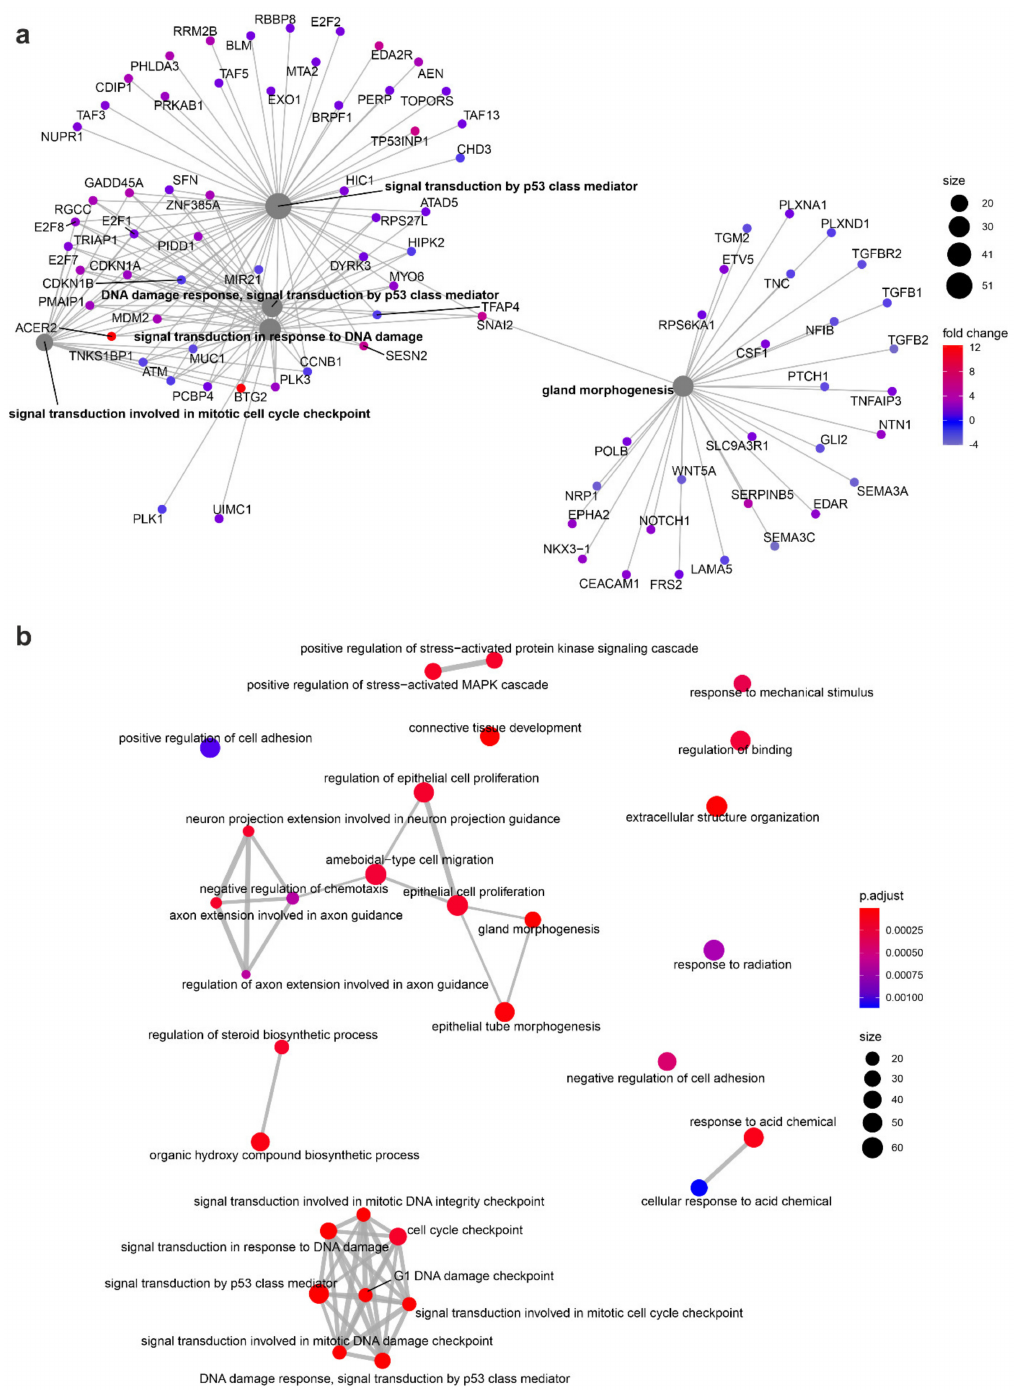
Figure 9. Visualisation of the relationships between biological processes and genes differentially regulated in cells irradiated in the prostate vs. the sham-irradiated cells. ( a ) Network plot showing linkages of genes and biological processes differentially expressed between irradiated and sham- irradiated cells in the prostate. The colour of the bubble represents a fold expression change between prostate and control. The size of the process bubble represents a number of differentially expressed genes; ( b ) Enrichment map showing relationships between processes enriched in cells irradiated in prostate compared to sham-irradiated. The size of the process bubble represents a number of differentially expressed genes. Lines connecting enriched processes are weighted by the radio of overlapping gene sets. This analysis was based only on the differentially expressed